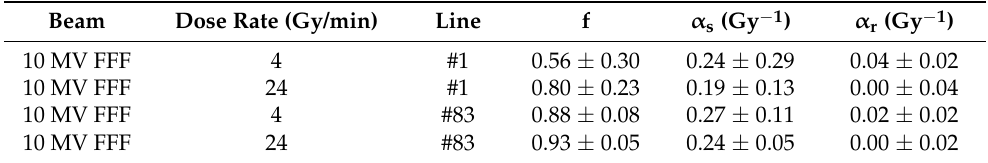
Table 2. Radiobiological parameters of the dose–response curves for cell killing of GSCs irradiated with 10 MV photons in the different beam configurations.